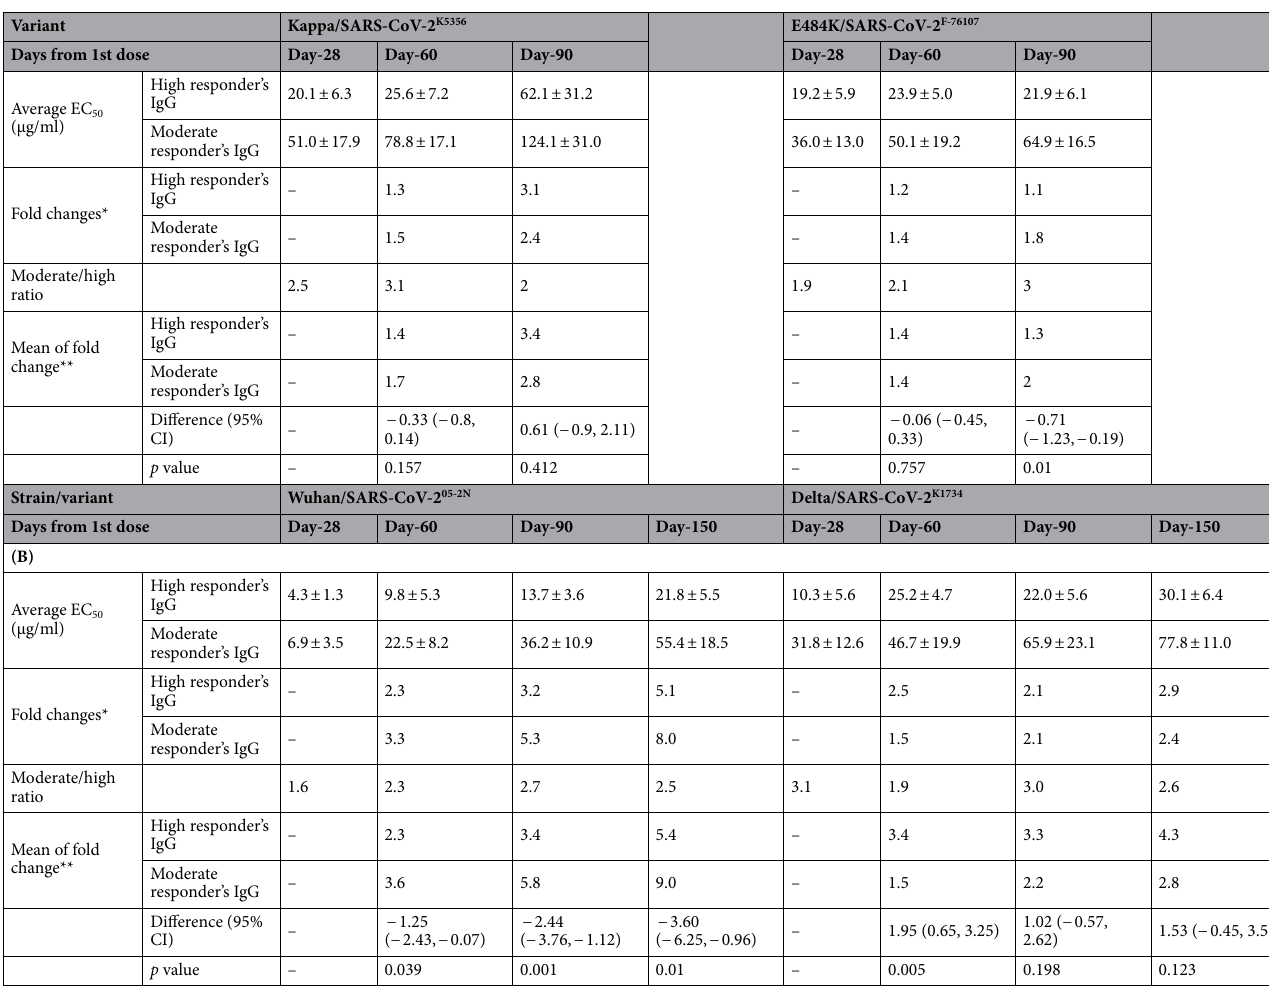
Table 4. Anti-SARS-CoV-2 activity of IgG fractions eluted from day-28, 60, 90, and 150 sera of high and moderate responders against VOCs and VUM. Average EC 50 values of IgG fraction eluted from sera of high (n = 13) or moderate (n = 12) responders, taken on day-28, -60, -90, and -150 post 1st vaccine doses, are indicated. *Fold change of EC 50 values compared to that of day-28 IgG. **Mean of fold change was calculated by arithmetic mean of each participant’s fold change at day-60, -90, and -150 against day-28. The difference between high and moderate responders using Student’s